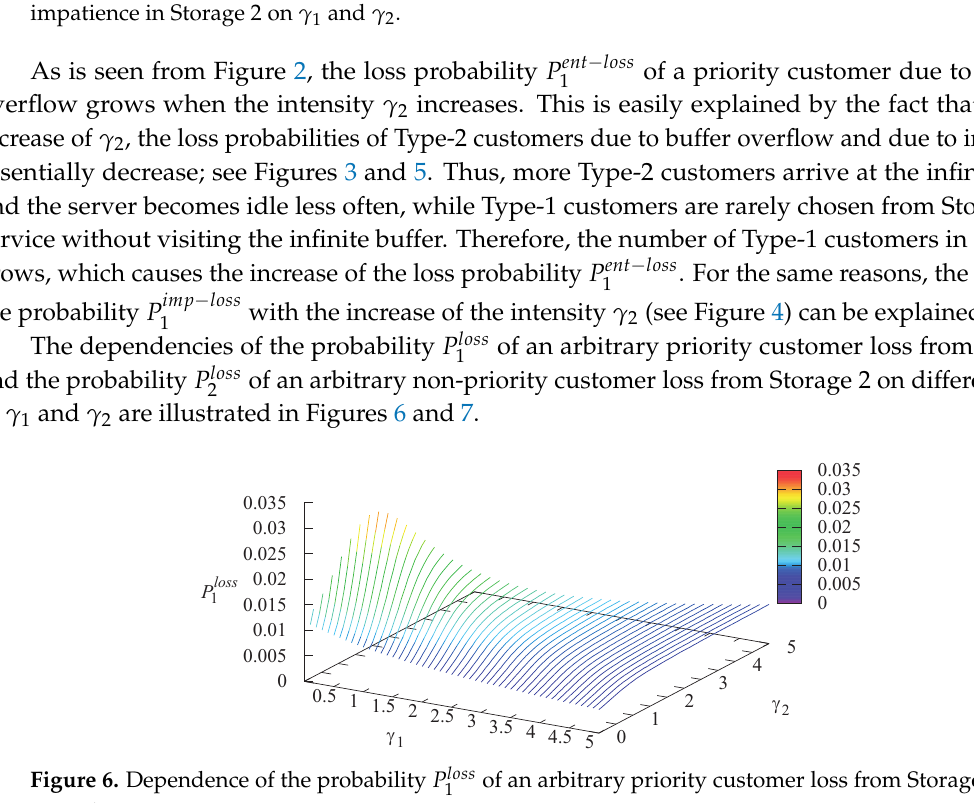
− loss that an arbitrary customer will be lost due to 2